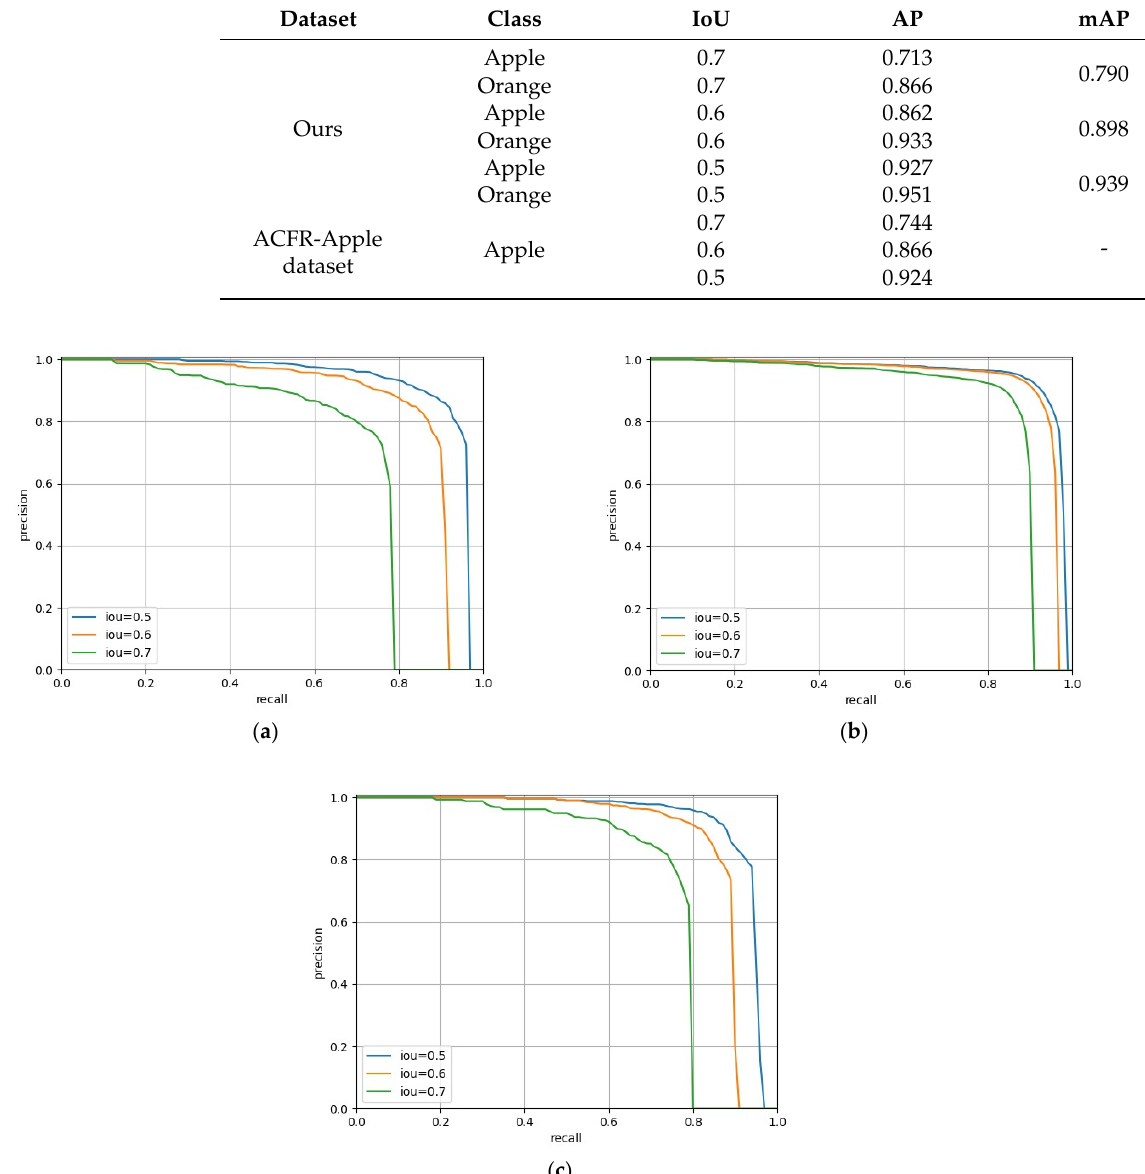
Figure 10. Precision-Recall curve of the model evaluation for fruit detection. ( a ) The P-R curve of apple detection in the collected dataset of this study. ( b ) The P-R curve of orange detection in the collected dataset of this study. ( c ) The P-R curve of apple detection in the ACFR-Apple